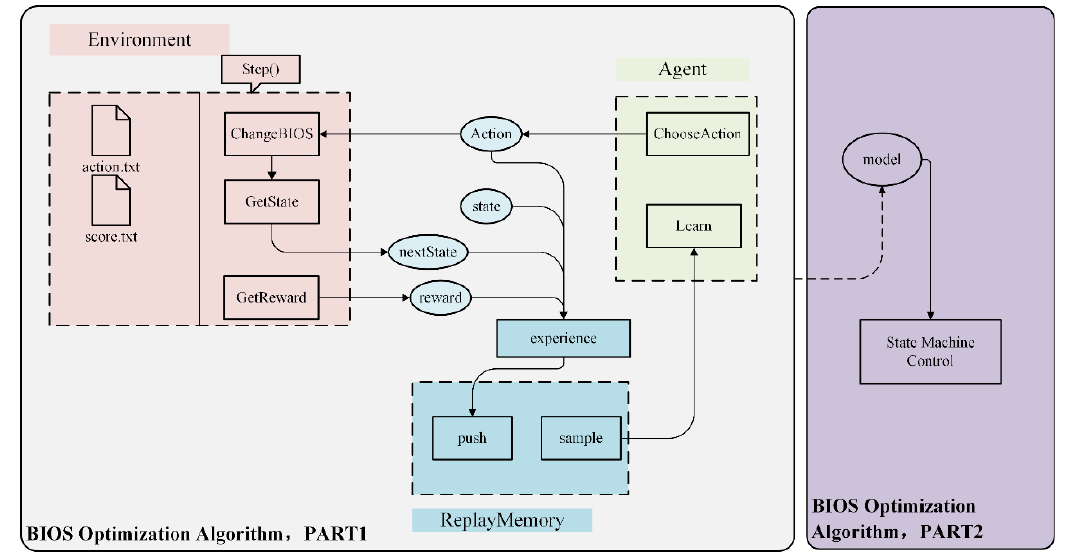
Figure 3. Structure of the BIOS optimization algorithm.